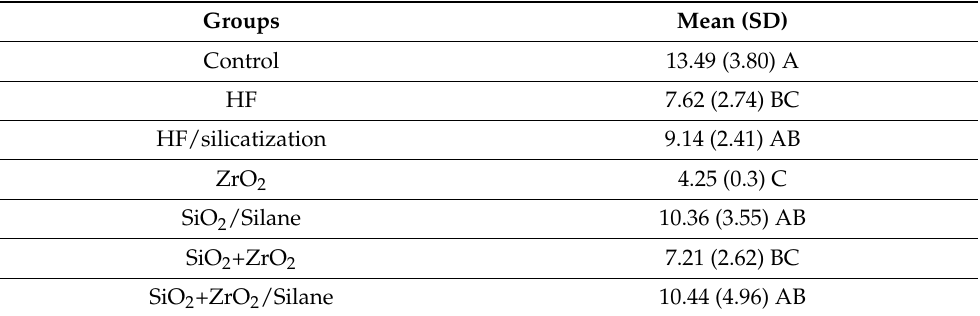
Table 3. Shear bond strength (MPa) after the different surface treatments. Data are presented as mean (standard deviation). ( α = 5%).